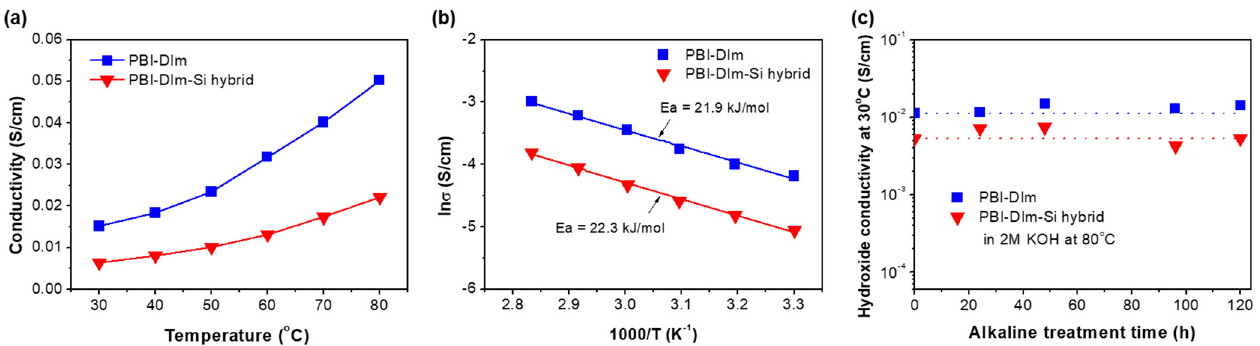
Figure 6. ( a )Temperature dependence of hydroxide conductivity, ( b ) the Arrhenius plot, and ( c ) hydroxide conductivity measured at 30 °C as a function of time during the alkaline treatment in 2M KOH at 80 °C, for the PBI-DIm and PBI-DIm-Si hybrid membranes.